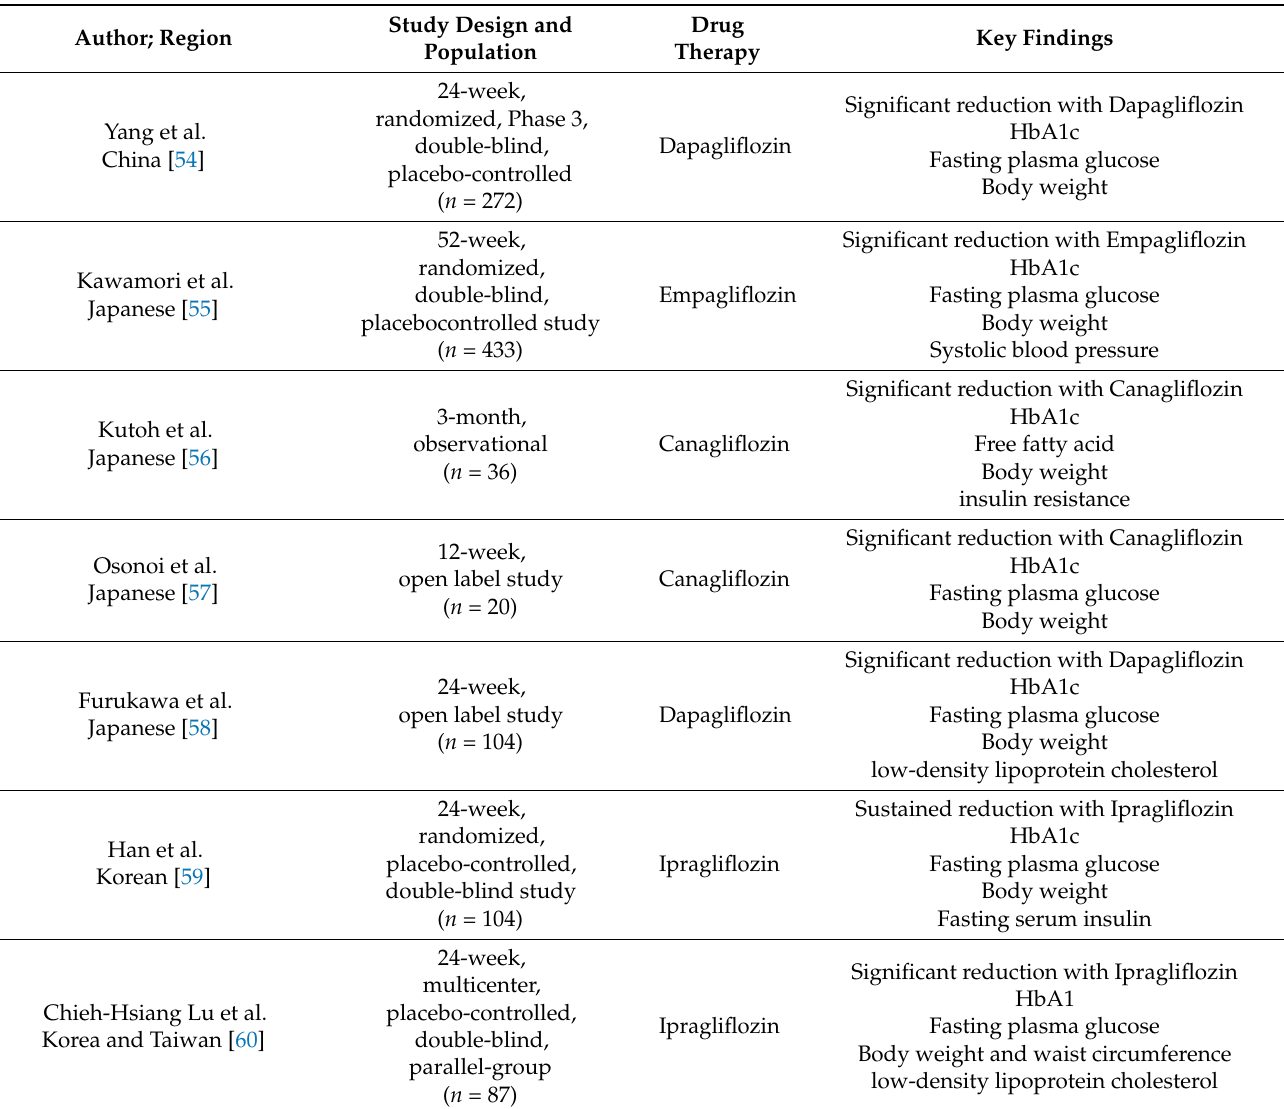
Table 1. SGLT2 inhibitors studies on both mono and double therapy in East Asians.